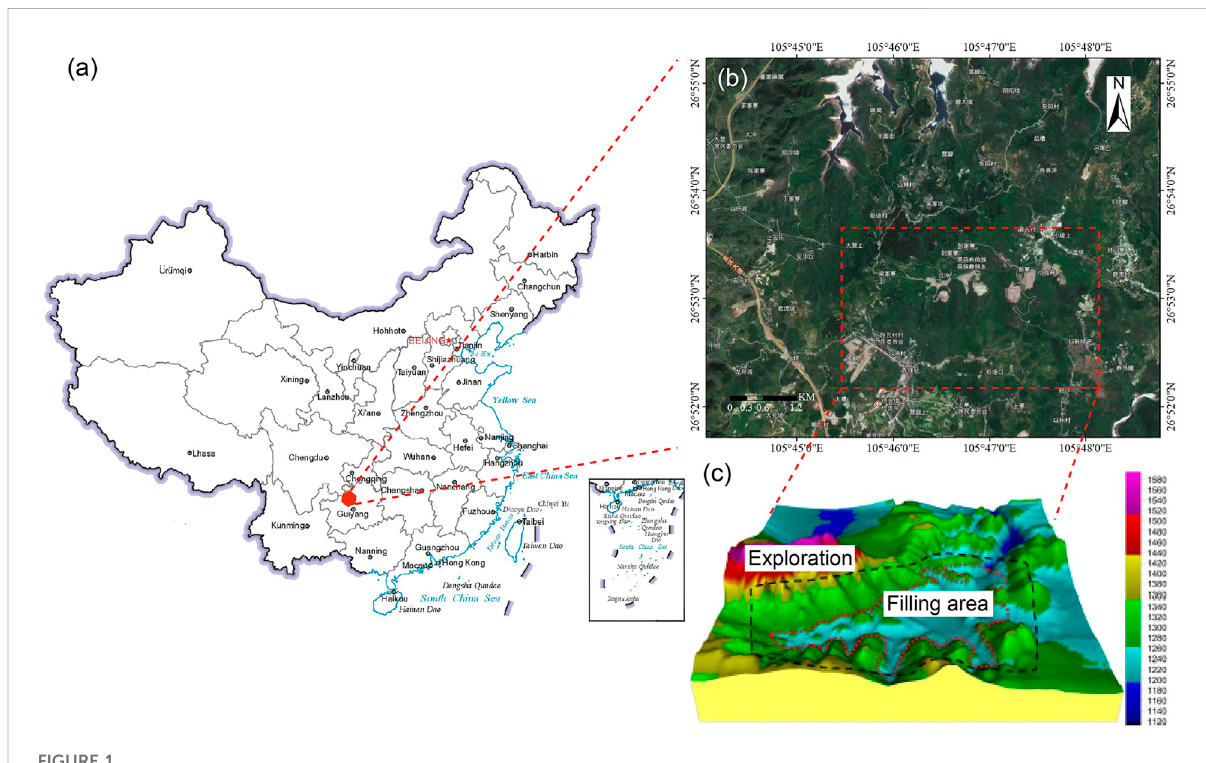
FIGURE 1 Location of the study